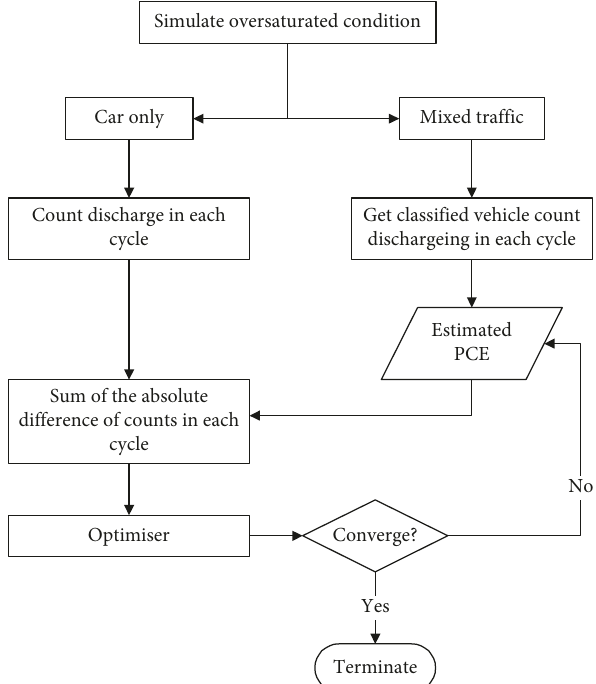
Figure 3: Methodology for saturation flow-based PCE